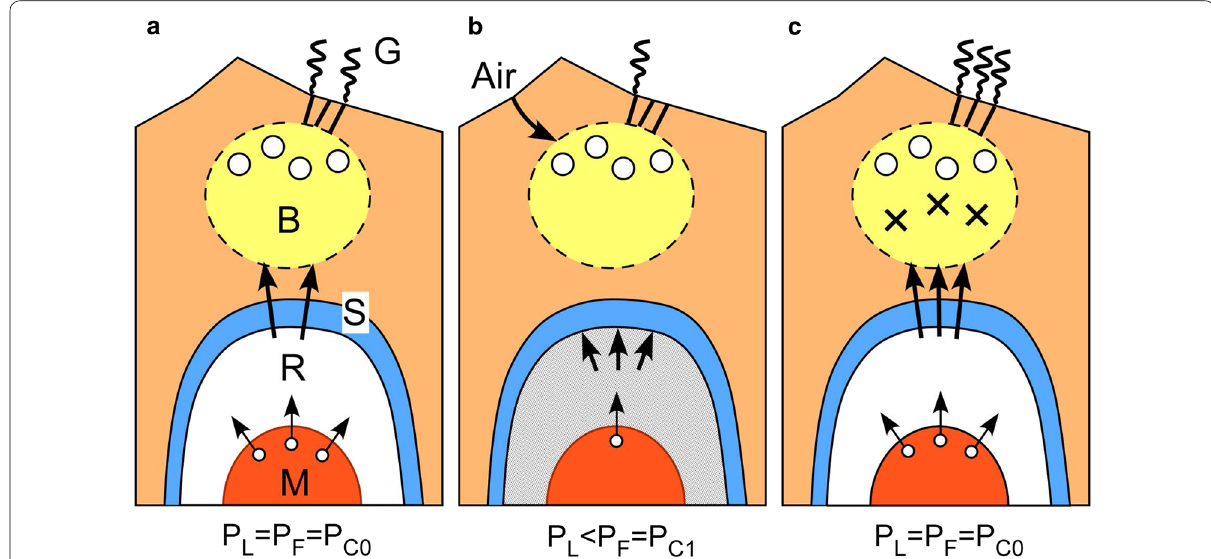
Fig. 12 Sequence at Hakone volcano before and after the earthquake swarm in May 2015. a Normal situation represented by the period in 2014. M: degassing magma, R: magmatic gas reservoir, S: sealing zone, B: hydrothermal system made of brittle crust, G: fumarolic gas, P L : lithostatic pressure, P F : magmatic gas pressure, P C 0 and P C 1 : gas pressure equilibrated with magma the composition of which is C O and C 1 in Fig. 11. b Sealing zone is restricting the magmatic gas transport to hydrothermal system, corresponding to the period in few months prior to May 2015. Air invasion was allowed into hydrothermal system. c Break of sealing zone in May 2015. A large number of earthquakes (cross‑marks) happened in hydrothermal